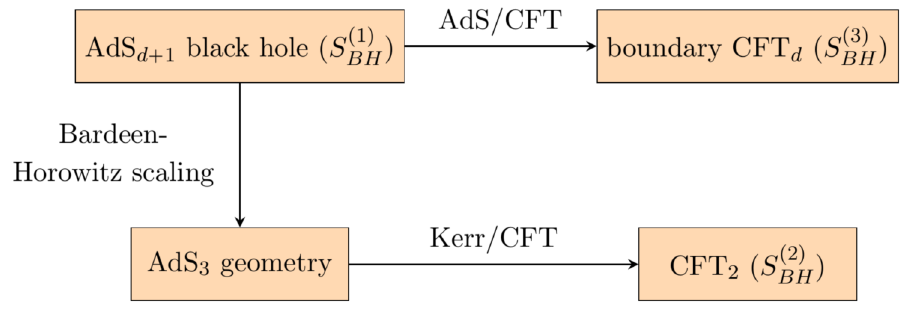
Figure 1 . The asymptotically AdS black hole entropy can be computed in three different ways ( S ( i ) ), and have found to give one universal result for the entropy. This is valid for both BPS black BH holes and near-extremal black